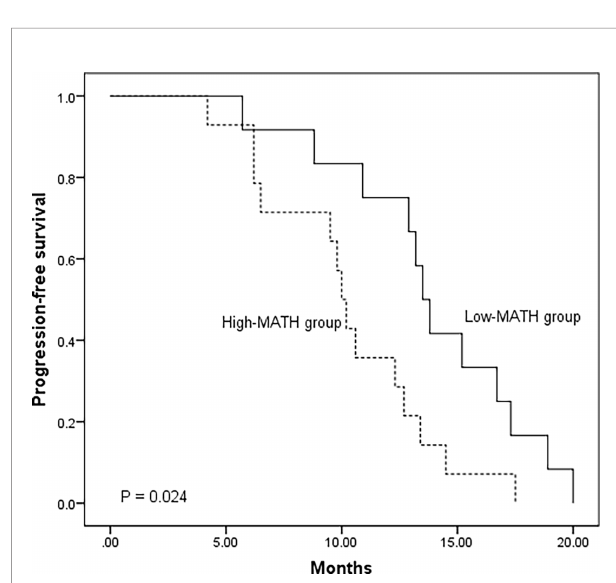
FIGURE 7 | Kaplan – Meier analysis of progression-free survival in 26 EGFR mutated lung adenocarcinoma patients according to mutant-allele tumor heterogeneity (MATH) score (Low-MATH group vs. High-MATH group). The Low-MATH group demonstrated a higher objective response rate (ORR) than High-MATH group (75% vs. 21%, P = 0.016). The PFS was signi fi cantly longer among patients in Low-MATH group than among those in High-MATH group (median PFS: 13.7 months vs. 10.1 months; P =